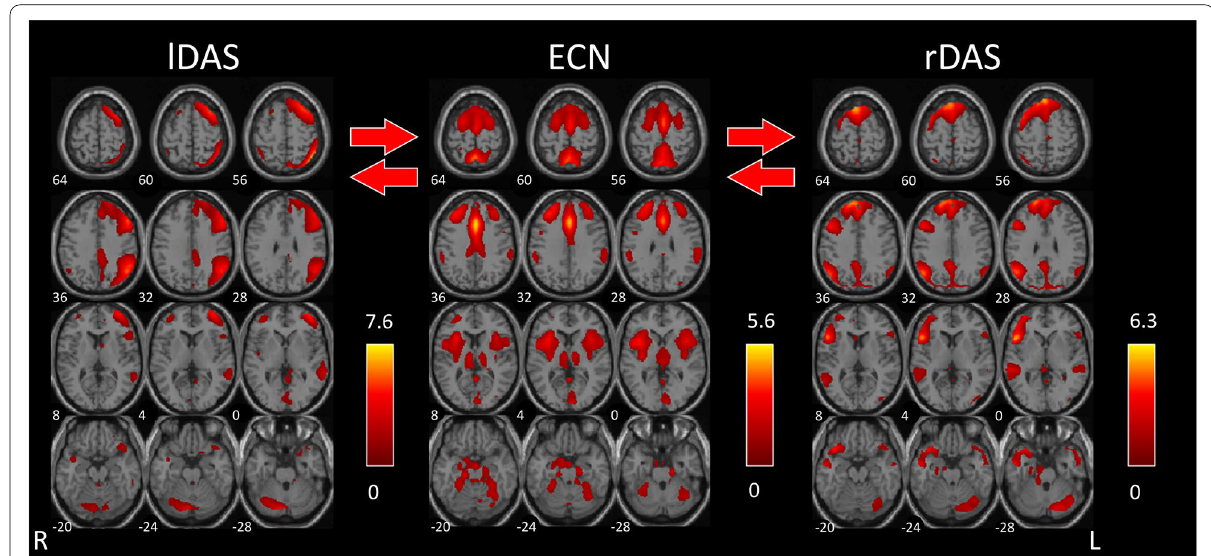
Fig. 2 In healthy subjects, left [lDAS] and right [rDAS] dorsal attention systems were significantly connected to the executive control network [ECN], after 4-min checkerboard visual stimulation vs. baseline resting state network connectivity. The images were co-registered in MNI space. The number under each brain image refers to the z-coordinate in Talairach space. The coloured bar on the right side of each network component reflects its functional connectivity map (FDR-corrected at p < 0.01)